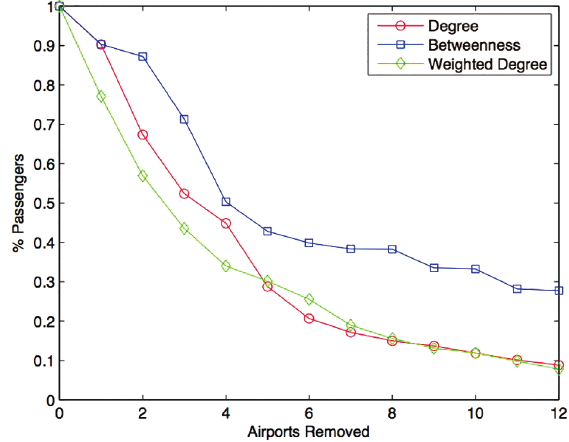
Figure 4 - Changes to the percentage of passengers by the total number of removed airports. For interpretation of the references to color in this figure, the reader is referred to the web version of this